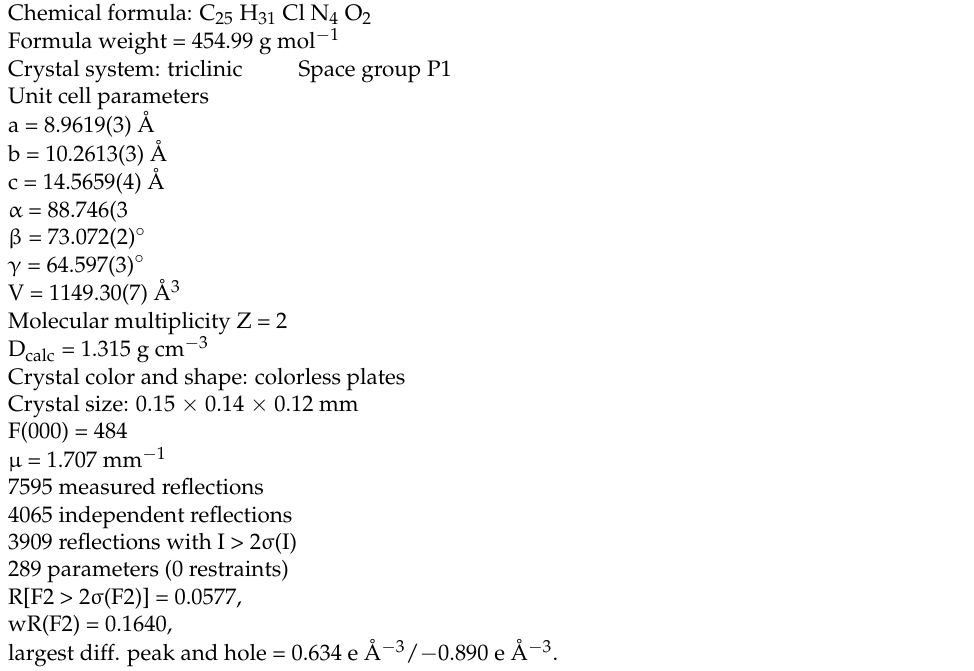
Figure 3. X-ray structures of 2h . Displacement ellipsoids are drawn at the 50% probability level. H atoms are shown as small spheres of arbitrary radii. Table 1. Crystal and experimental